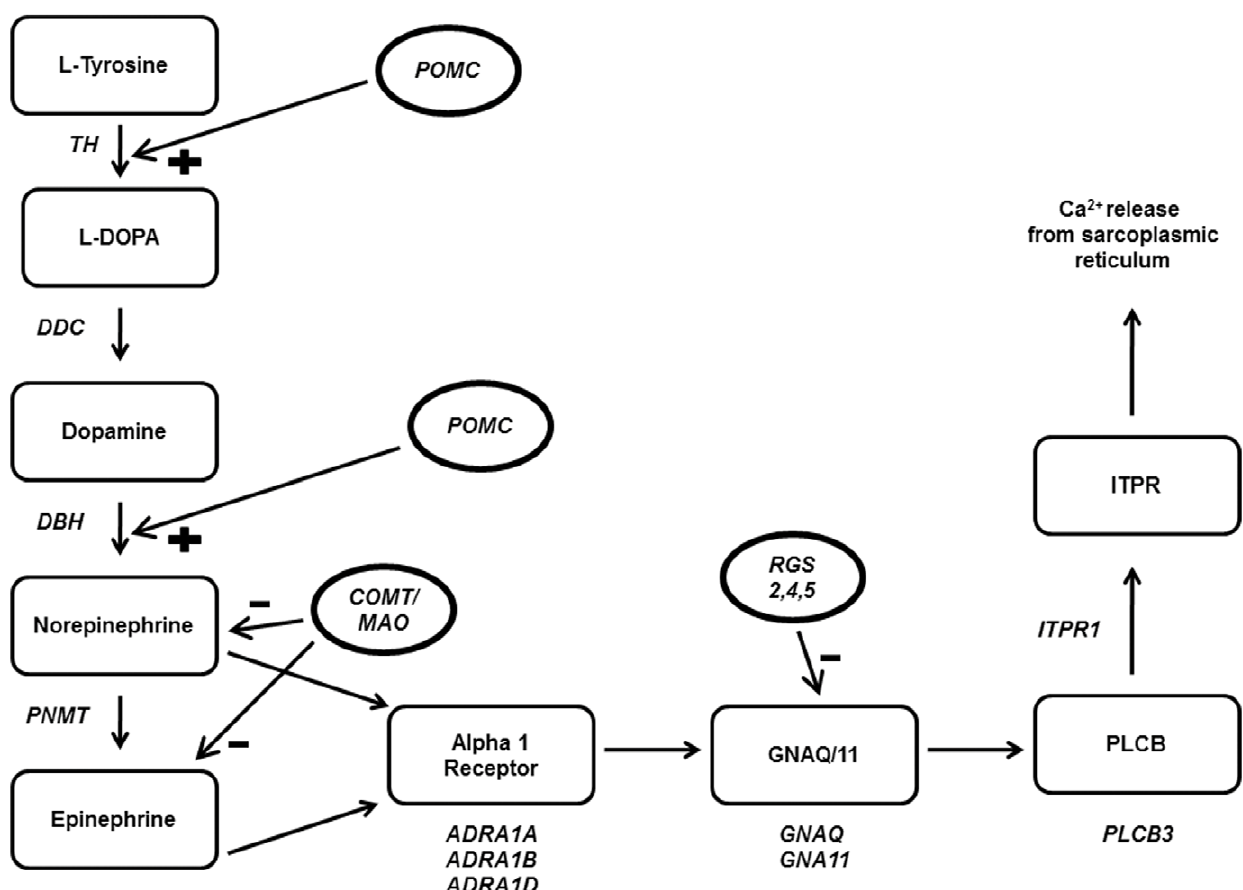
Figure 1. ADRA1 pathway associated genes. Gene names are in italics. Regulators are in circles. TH, tyrosine hydroxylase; DDC, dopa decarboxylase; DBH, dopamine beta hydroxylase; PNMT, phenylethanolamine N-methyltransferase; ADRA1A, ADRA1B, ADRA1D, adrenergic alpha 1 receptors; GNAQ, guanine nucleotide binding protein, Q; GNA11, guanine nucleotide binding protein, alpha 11; PLCB3, phospholipase C, beta 3; ITPR1, inositol 1,4,5-triphosphate receptor, type 1; POMC, proopiomelanocortin; COMT, catechol-o-methyltransferase; MAO, monoamine oxidase; RGS 2,4,5, regulator of g-protein signaling.